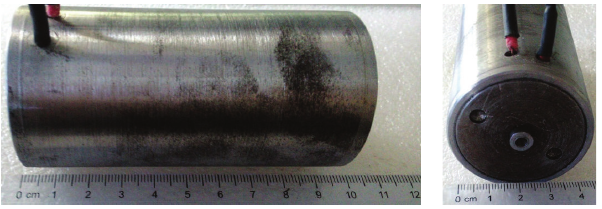
Figure 17: Photo of linear-arrayed GMA